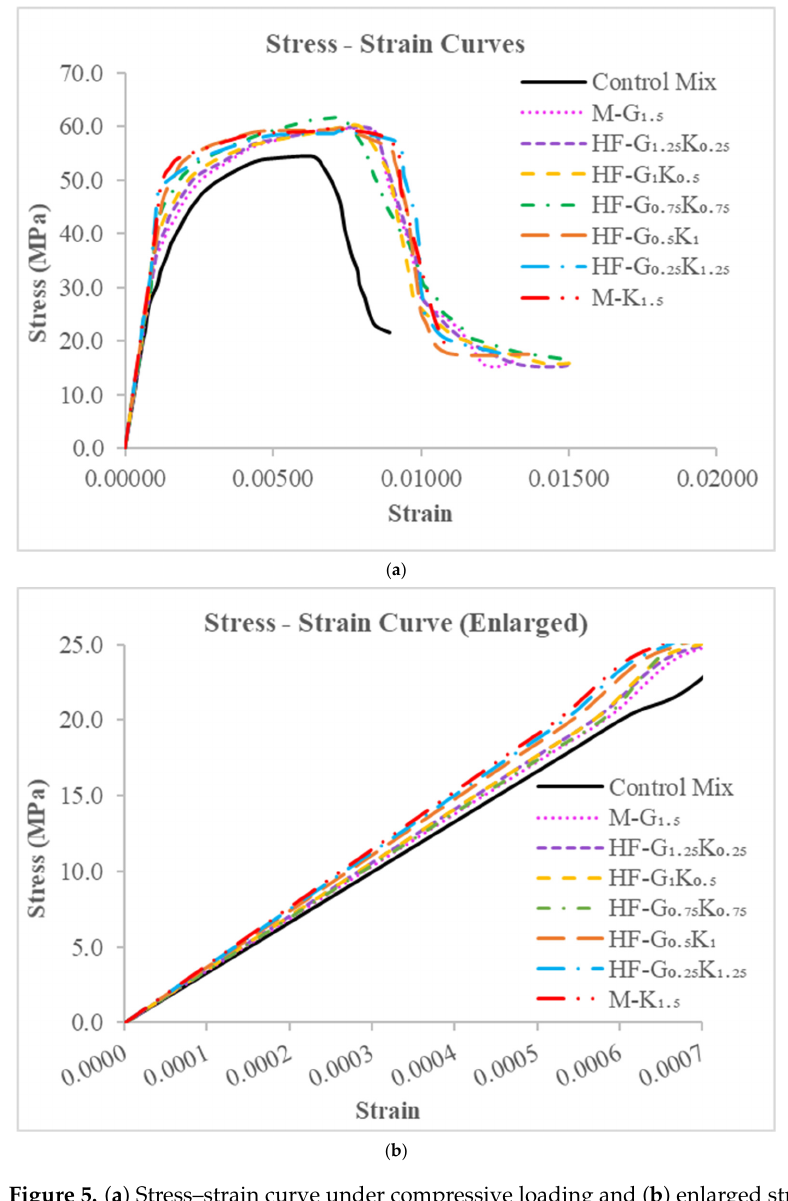
Figure 5. ( a ) Stress–strain curve under compressive loading and ( b ) enlarged stress–strain curves up to 25 MPa stress and 0.0007 strain.